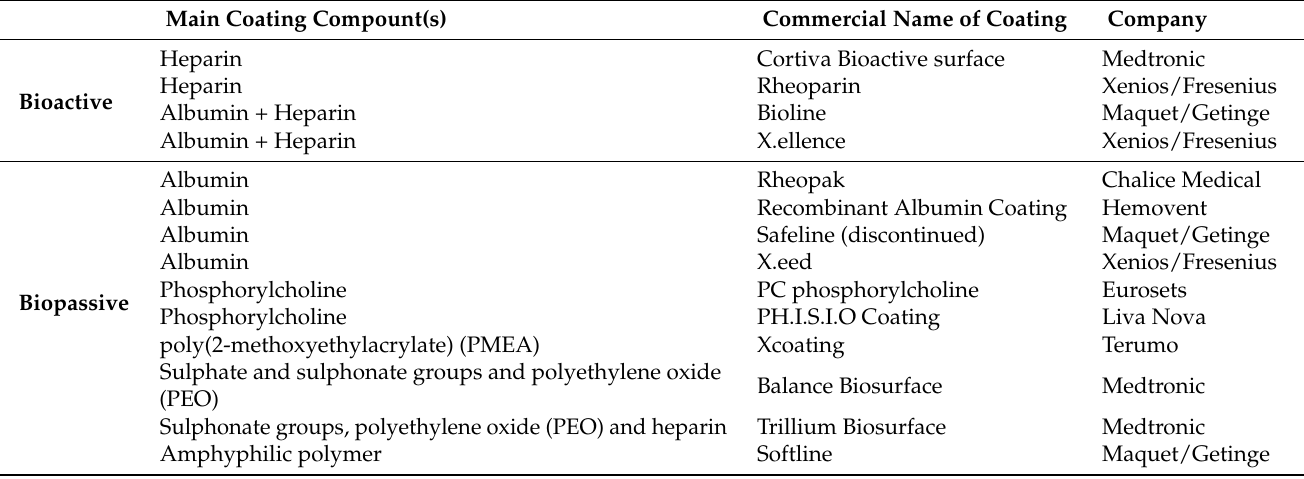
Table 2. Overview of the commercially used coatings in extracorporeal life support circuit components. Main Coating